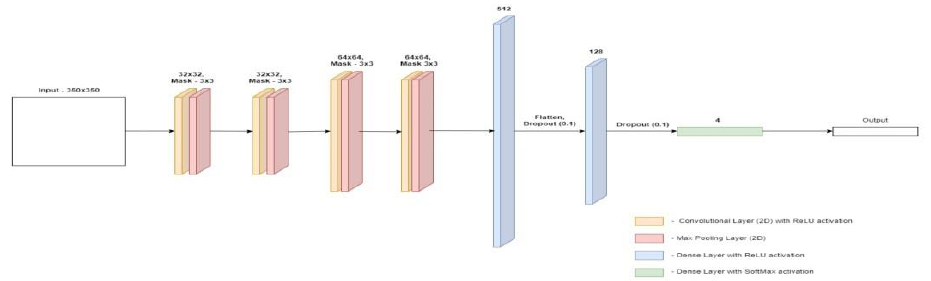
Figure 9. Architecture of the second convolutional neural network model.